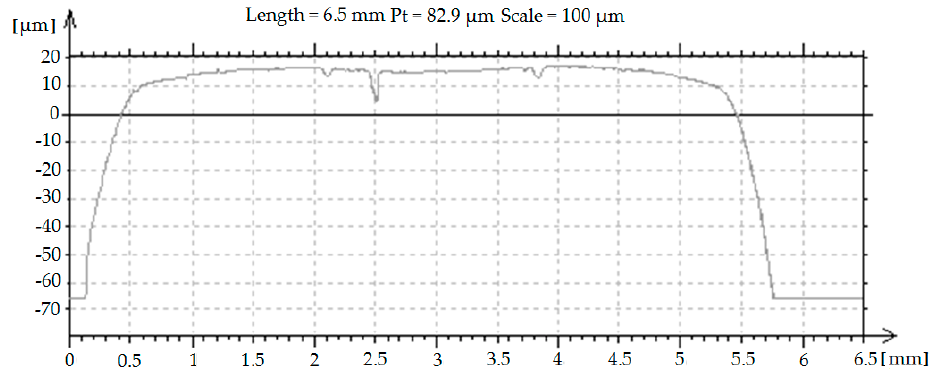
Figure 6. Exemplary profile of the asperities after roller burnishing.